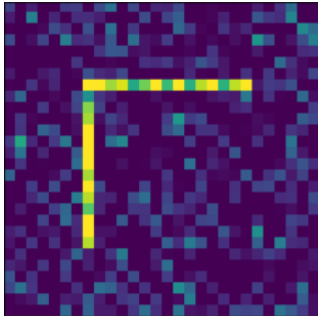
Figure 19. Original object, with level 2 noise.